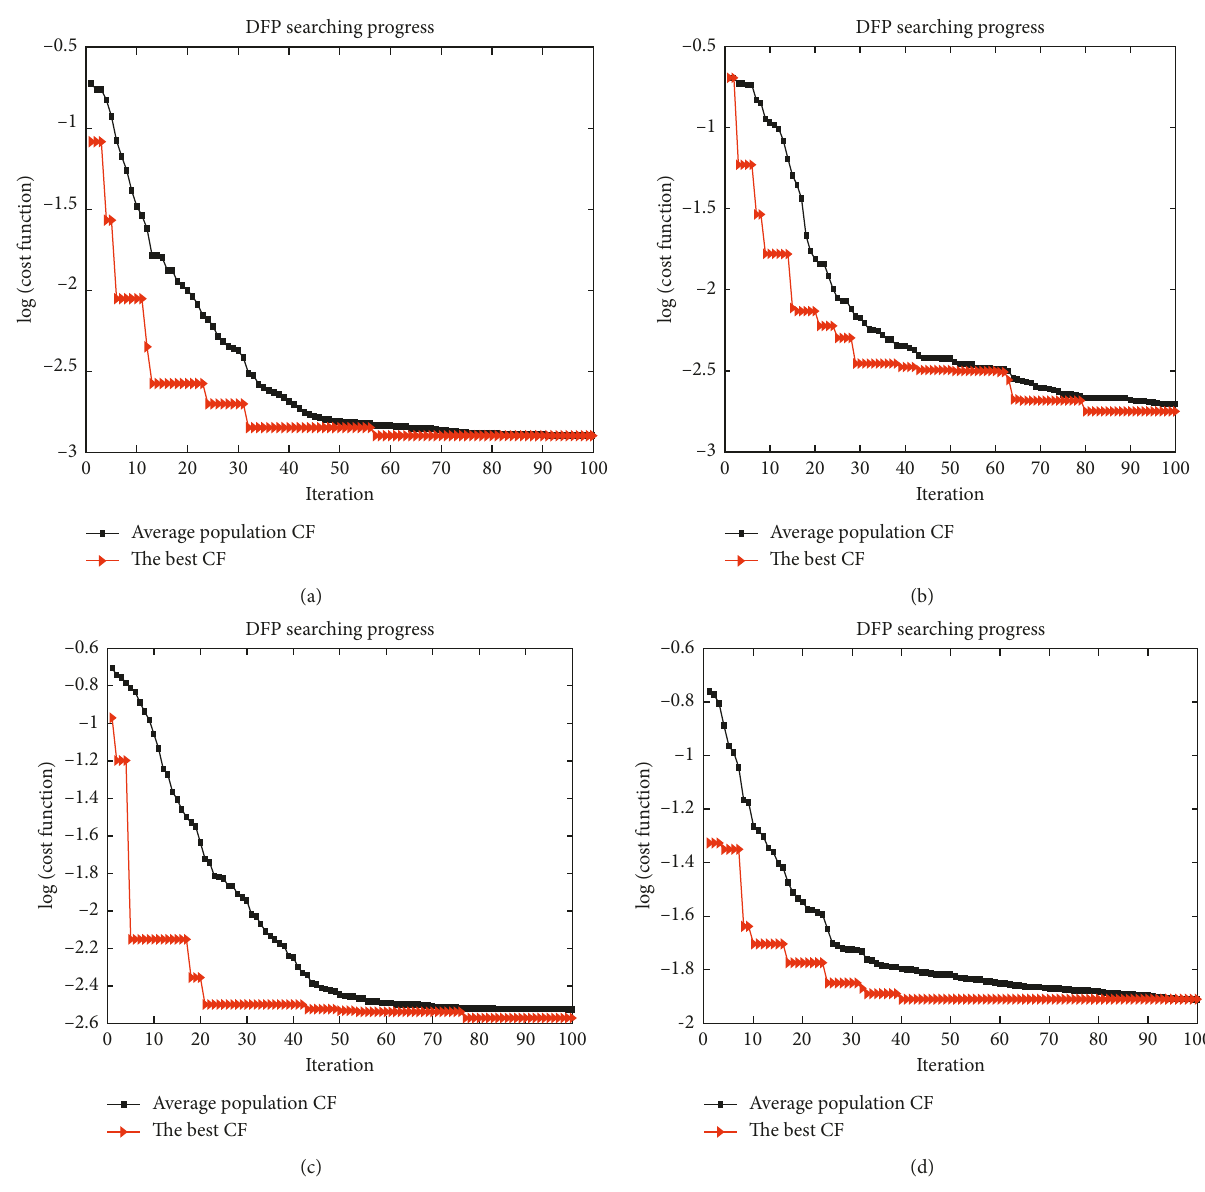
Figure 8: Optimizing result of MO-EDCR that employs (a) the Roberts algorithm, (b) the Prewitt algorithm, (c) the Sobel algorithm, and (d) the Canny algorithm. Table 1: The optimized model parameters. Edge